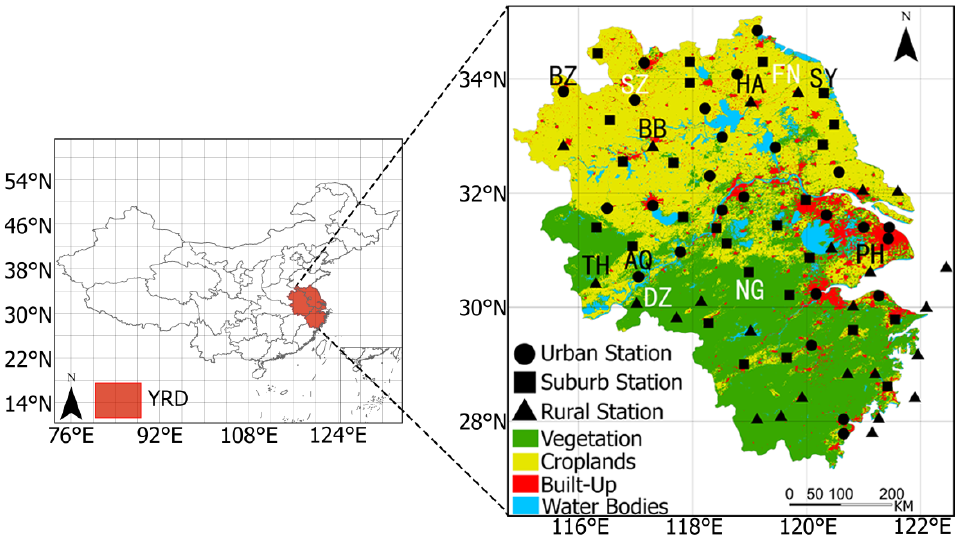
Figure 1. Map of the YRD showing land use, the classification of meteorological stations, the relocated stations (black) and reference stations (white) (initials of the station names are given above the stations). The LULC maps in 2016 were from the MODIS MCD12Q1 product at a 0.5 km × 0.5 km resolution.